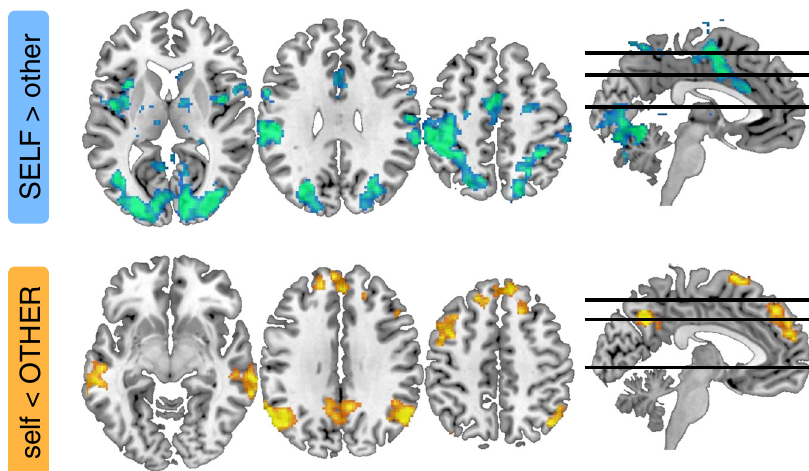
Fig. 4 Whole-brain activations for self- and other-related processing during decision phase. Images display clusters surviving whole-brain correction ( p < 0.05, FWE-corrected for multiple comparisons at a cluster-de fi ning threshold of p < 0.001, uncorrected) for the contrast between self- and other-trials during the decision phase (cold: SELF > other; warm: self < OTHER). Images are shown at p < 0.001, uncorrected. All clusters surviving whole-brain correction during the stimulus and gamble phases are detailed in Supplementary Tables 2 and 3.